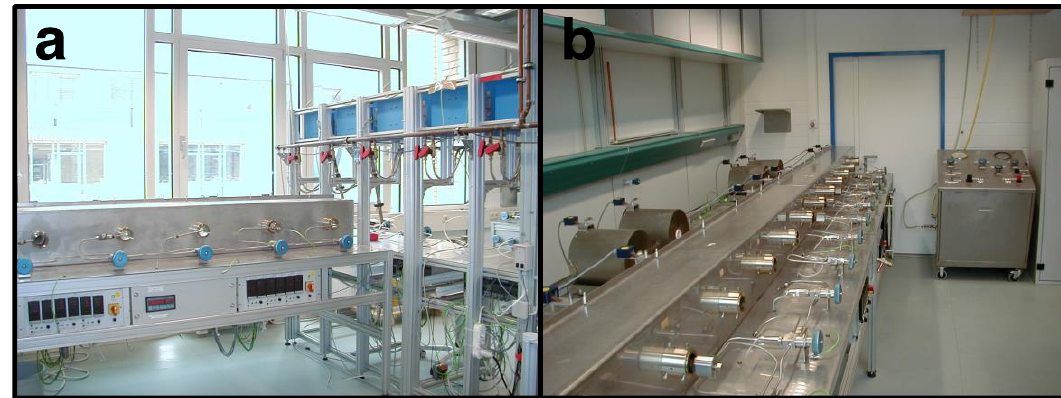
Figure 1: a) 200 MPa line and rapid quench line, b) 500 MPa